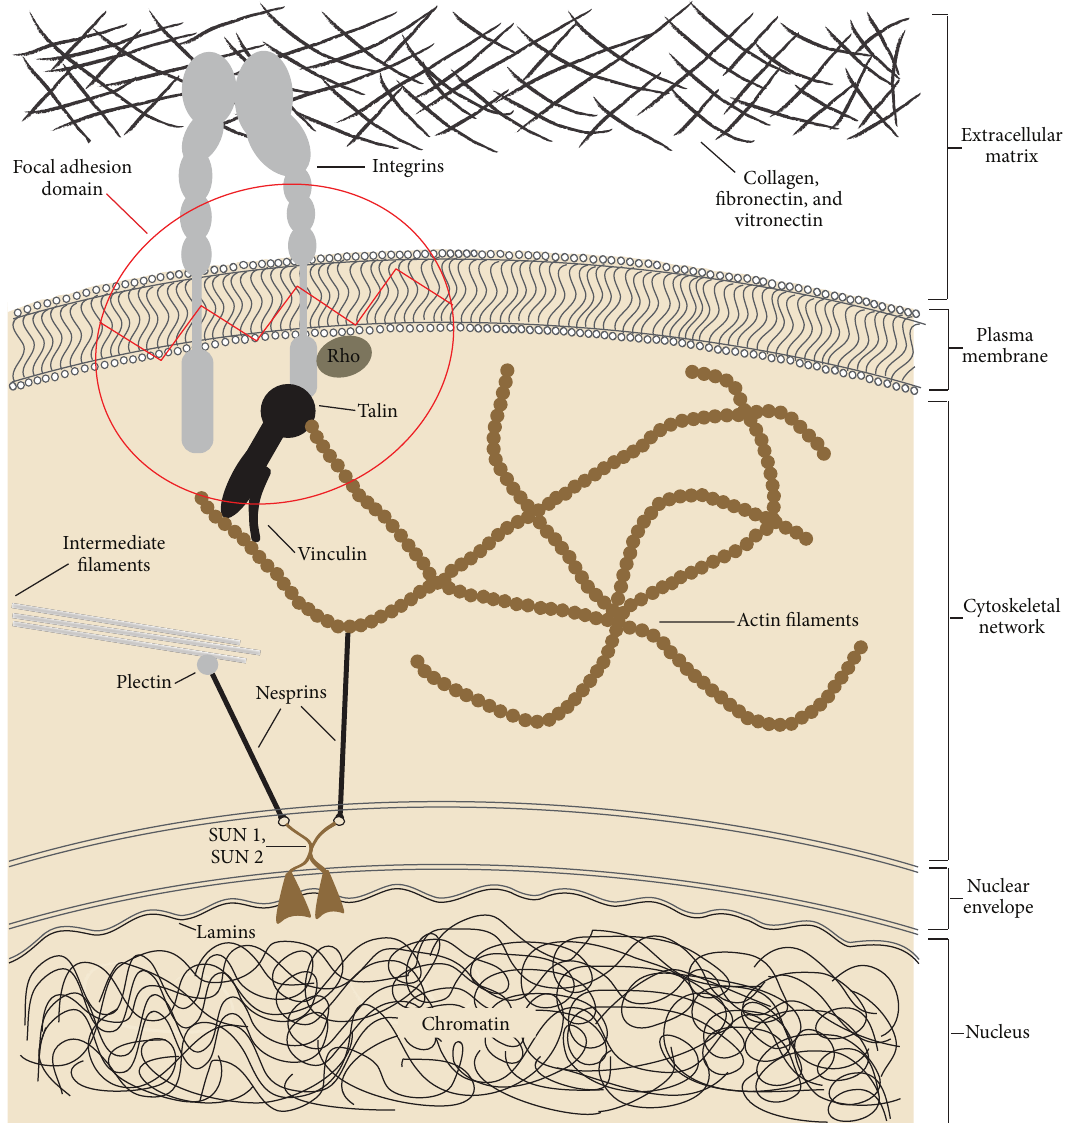
Figure 1: Focal adhesions are protein complexes which connect extracellular matrix proteins such as collagen, fibronectin, and vitronectin to the intracellular actin cytoskeleton by way of integrins and talin. The extracellular matrix derived strain causes configurational changes in the focal adhesion protein talin, exposing vinculin-binding molecular sites. This results in recruitment of vinculin leading to reinforcement of the focal adhesions and establishing a physical link between extracellular matrix and the nuclear envelope through the agency of the integrin-talin/vinculin-actin filament molecular chain. This chain of linked molecules ultimately transmits signals from the mechanically stressed extracellular matrix to the nucleus via the nuclear envelope lamins, nesprins, SUN1, and SUN2. Rho GTPase regulates cytoskeletal organizationandinresponsetoextracellularmechanicalstimuli,Rhoactivationpromotesmyosincontractilityandinducesthereinforcement of focal adhesions [22, 23,